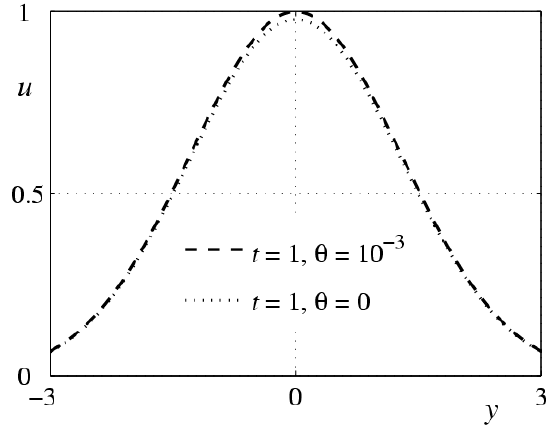
Figure 2. Behavior of solutions to problem (9), (10) and problem (12), (13) with the initial function (cid:8) − (cid:9) 2 u 0 ( y ) = exp dy 2 for d =